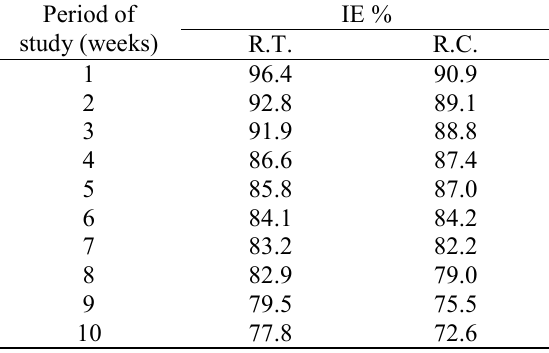
Table 5. Shelf life of SFCN